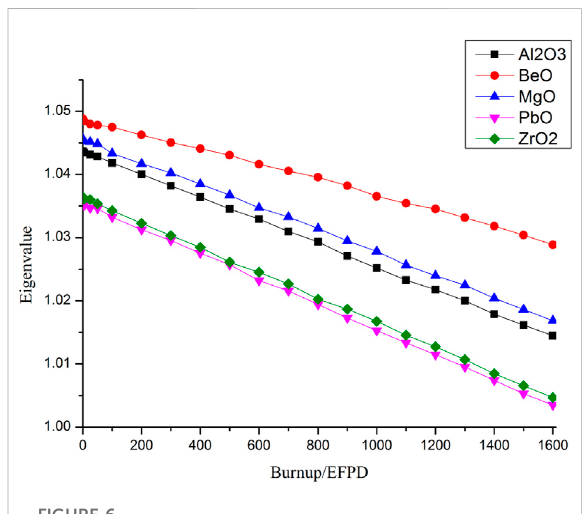
FIGURE 6 Burnup calculation results of the re fl ector material analysis.